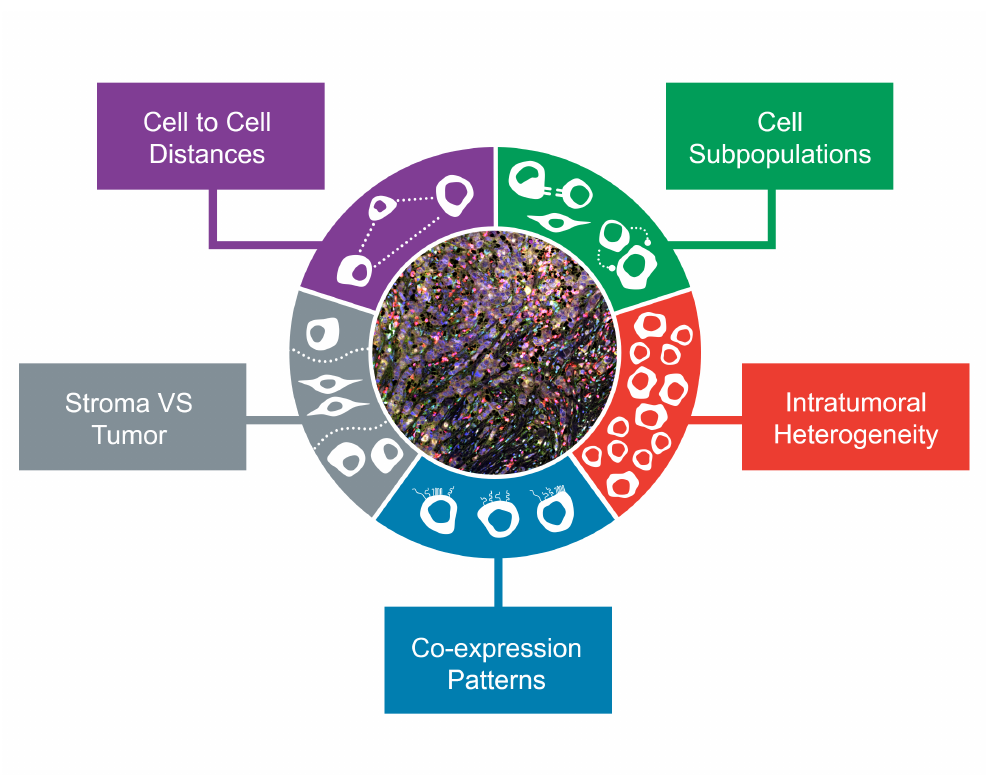
Figure 1. Hallmarks of multiplexed in situ TIME profiling. Different aspects which can be covered by the various multiplex assays and techniques enable a comprehensive characterization of the tumor microenvironment (TIME) in breast